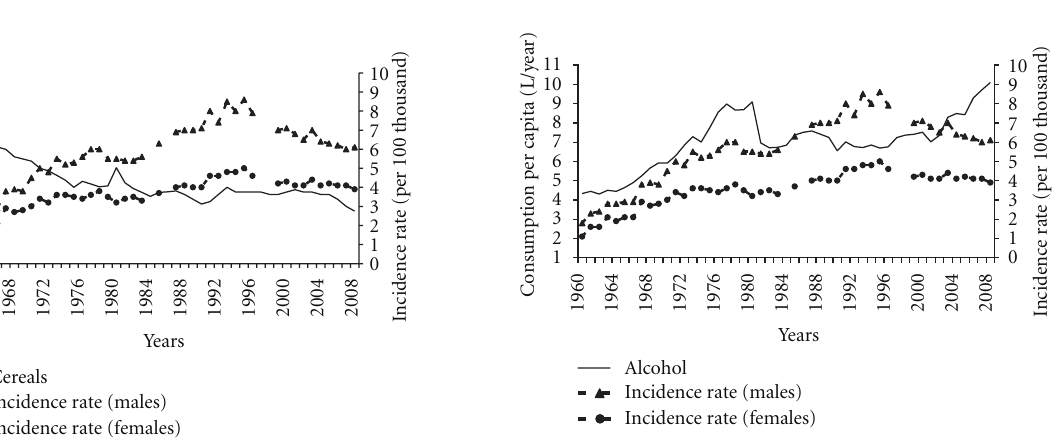
Figure 9: Cereals consumption and pancreatic cancer morbidity 1960–2008.